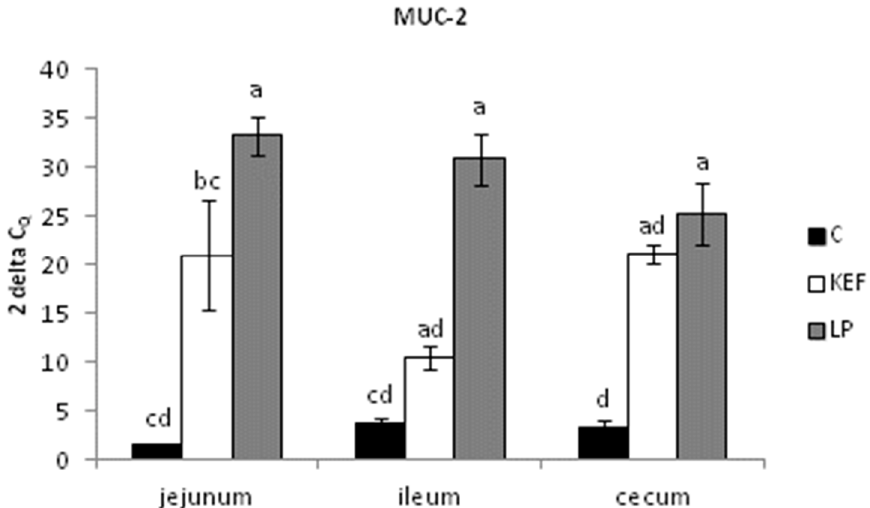
Figure 3. Relative expression level of MUC-2 (jejunum, ileum, cecum) in mice ( n = 6). Results at each timepoint are the median of 2 – ∆ Cq . Means with different superscripts in individual intestinal segments are significantly different. ab p < 0.05; ac p < 0.01; ad p < 0.001.